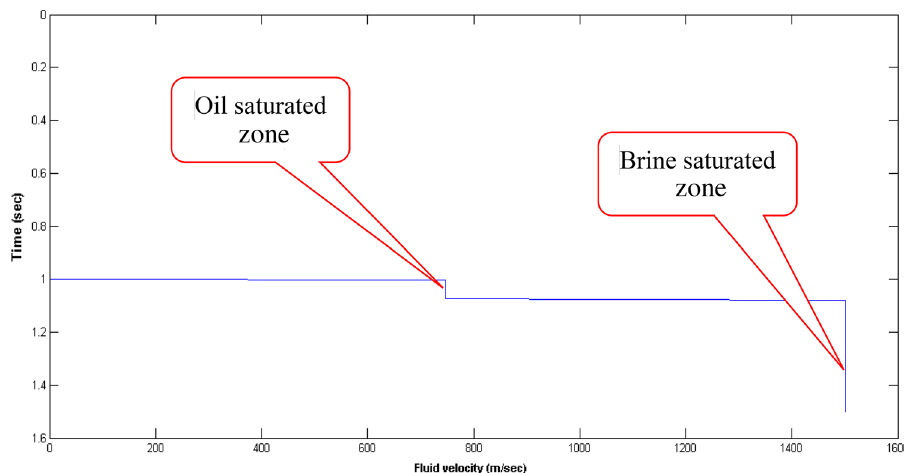
Fig. 10 Fluid velocity plot of case 2